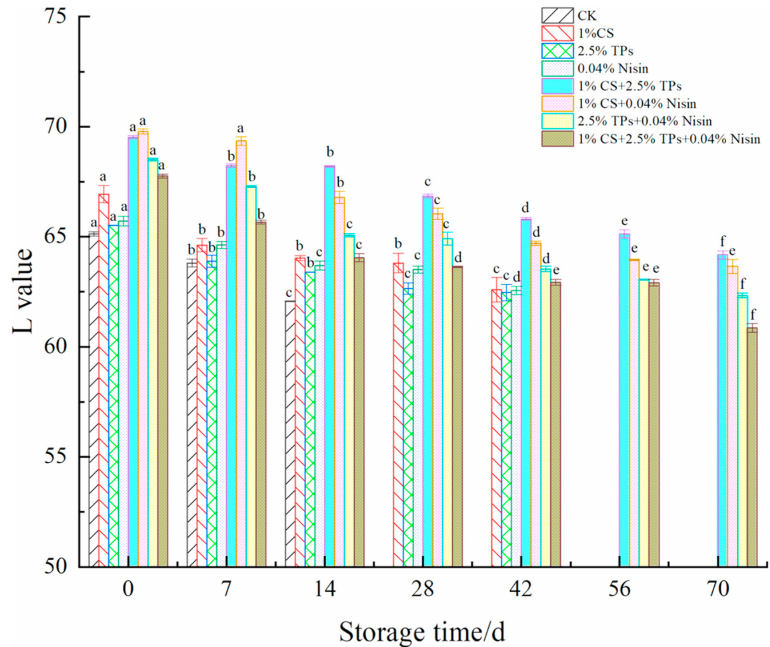
Figure 4. Effects of compound preservatives on the “L value” of plant-based meat. a–f Values with different superscripts in the same preservative indicate significant differences ( p < 0.05). CS, chitosan; TP, tea polyphenols; CK, control group.